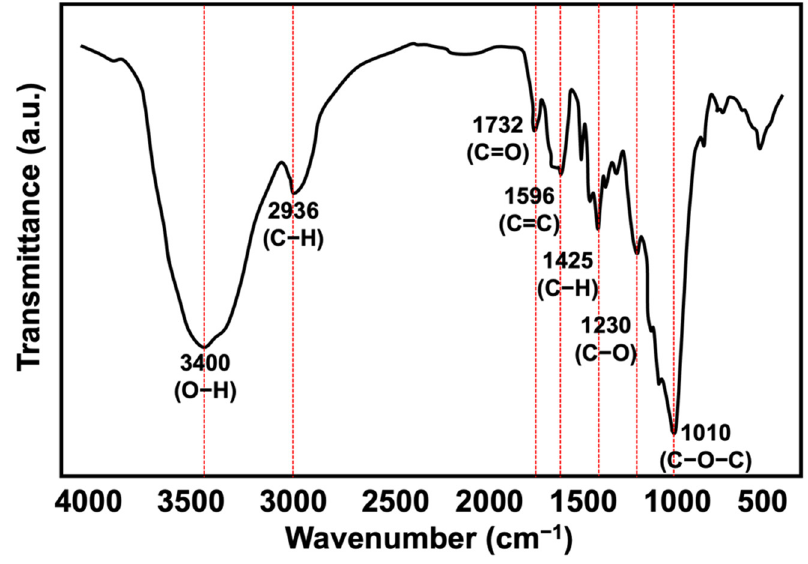
Figure 2. FTIR spectrum of KP.